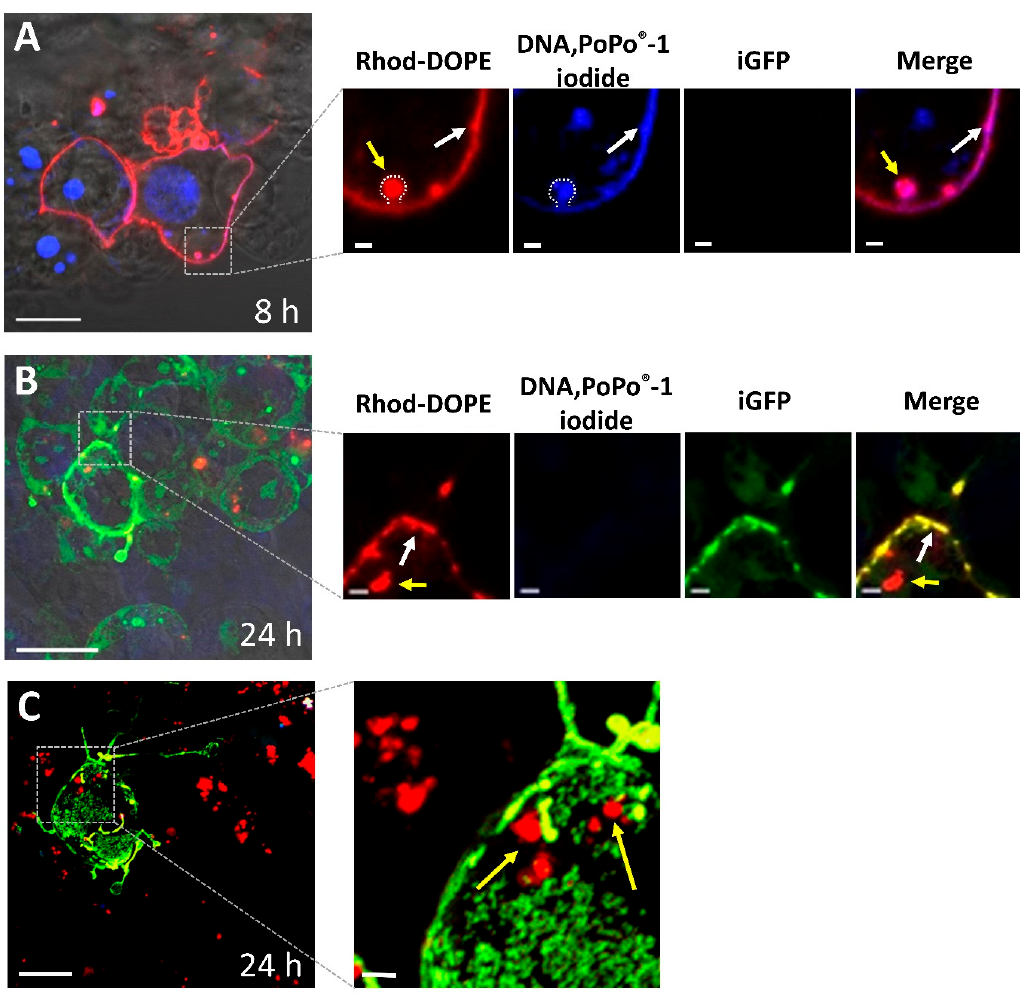
Figure 3. Confocal fluorescence microscopy images of HEK293T cells at 8 h ( A ) and 24 h ( B , C ) post-transfection using a lipid mixture containing OH4/DOPE 1/1 (n/n) in a complex with pDNA of the molecular clone HIV-1 JR-FL Gag-iGFP at an N/P ratio of 4. To show typical three-color merged images, Rhod-DOPE (red), pDNA labelled with PoPo ® -1 iodide (blue), and iGFP (green) are selected. Colocalization of Rhod-DOPE and pDNA-PoPo ® -1 iodide in the cell membrane (white arrow) is displayed; Rhod-DOPE cell inclusions were marked with yellow arrows. Observed omega-like structures are marked with a dot line. After 24 h ( B , C ) post-transfection, the expression of the molecular clone HIV-1 JR-FL Gag-iGFP is detectable (green), and viral budding formations can be observed on the surface (cut-out from C). The images were obtained with an inverted confocal laser microscope (Zeiss cLSM 780). For image ( C ), a z-stack of optical sections through the samples was visualized using Zeiss ZEN2011 software to generate a 3D projection. The scale bars represent a length of 10 μ m, except in the image cut-outs, where they represent a length of 1 μ m.